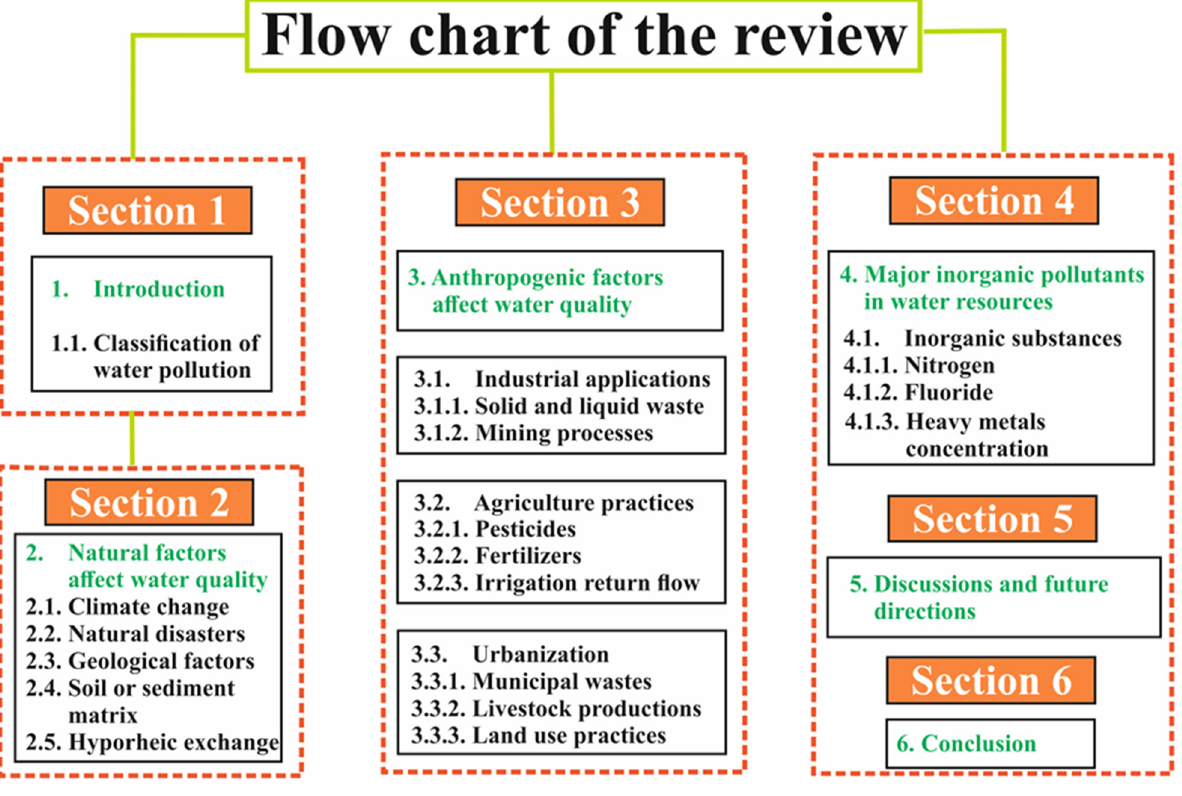
Figure 2. The flow chart of the review describes the outline of the study. Classification of Water Pollution